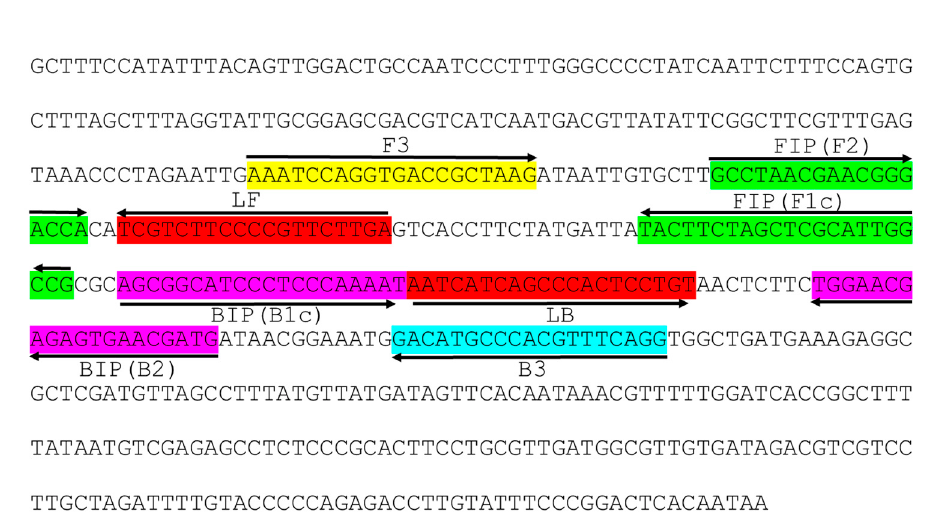
Figure 1. Location and partial sequence of loop-mediated isothermal amplification (LAMP) primer sets targeting Cucurbit leaf crumple virus (CuLCrV) -specific DNA. Locations for two outer (F3 and B3), two inner (FIP [F1c-F2], and BIP [B1c-B2]) and two looping (LF and LB) primers are indicated in